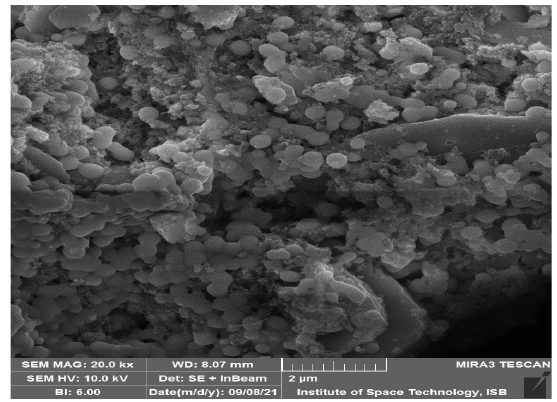
Figure 3. SEM of AgNPs. Figure 3. SEM of